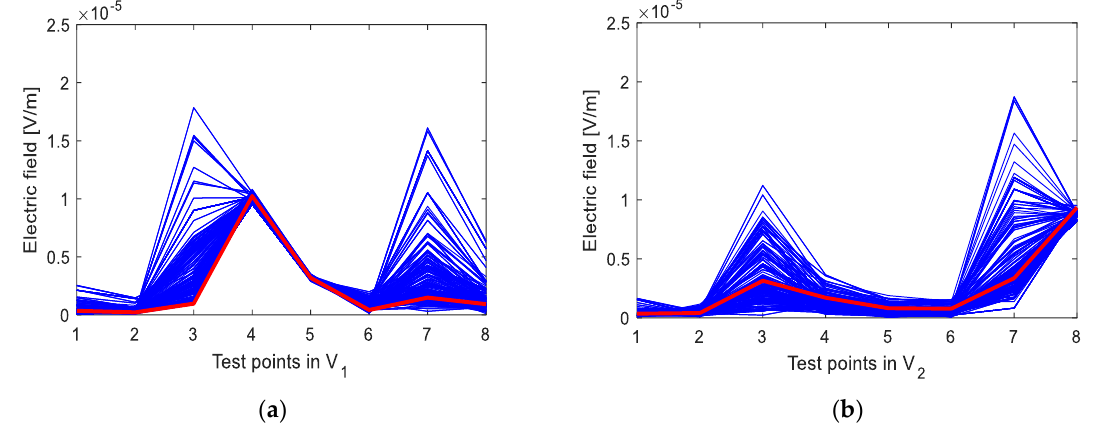
Figure 12. Magnitude of the electric field in ( a ) the N 1 test points of volume V 1 and ( b ) the N 2 test points of volume V 2 , due to the entire population (blue curves) and one optimal MOGA solution (red curve), with constraint N r = 5.